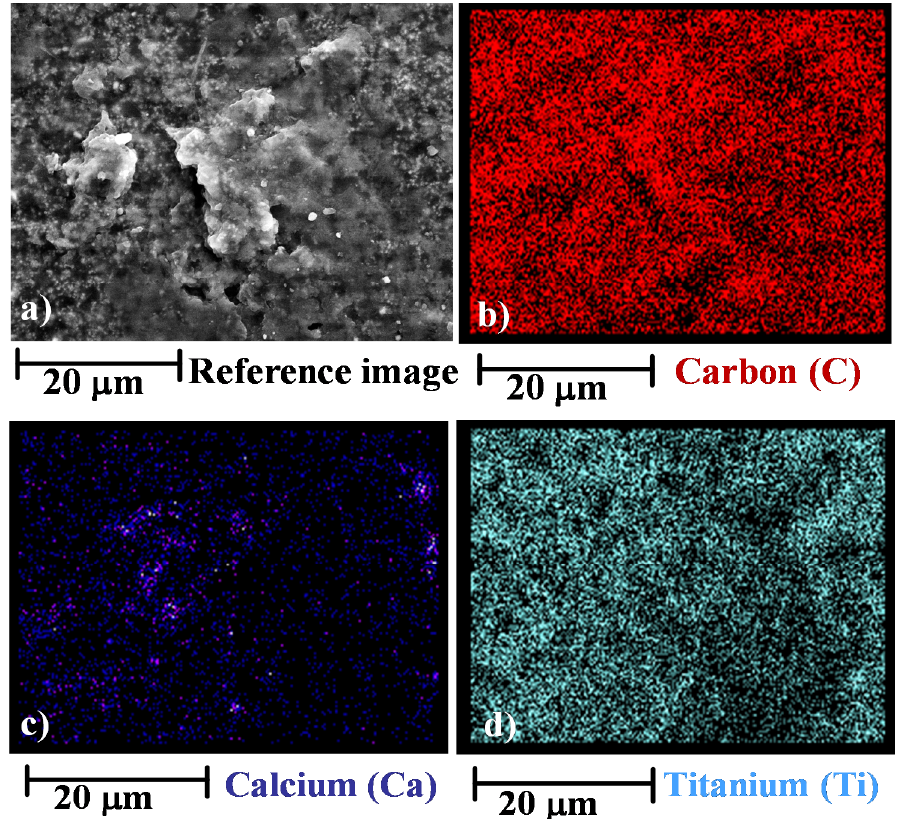
Figure 3. Energy dispersive X-ray (EDX) performed on the fracture surface of the sample 01GNPs (550): ( a ) reference image; ( b ) map distribution of C; ( c ) map distribution of Ca; ( d ) map distribution of Ti.